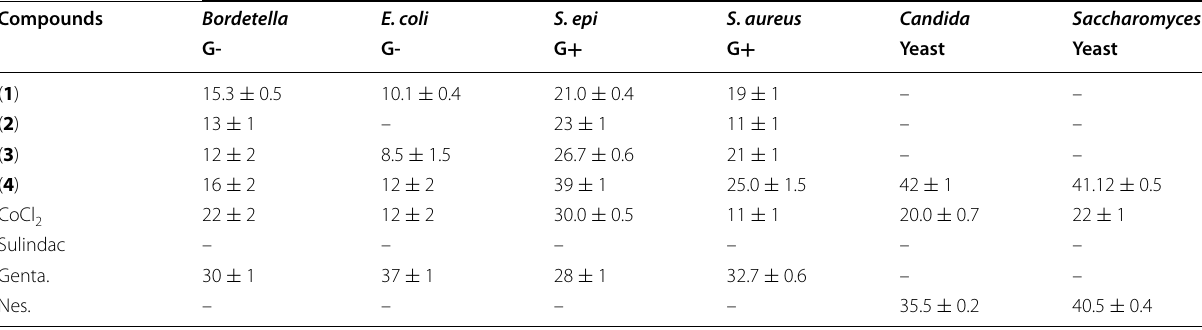
Inhibition zone diameter (IZD) in mm, all microorganisms were resistant to DMSO. The data stated as average complexes and the standards was 30 mg/5 mL in DMSO (6